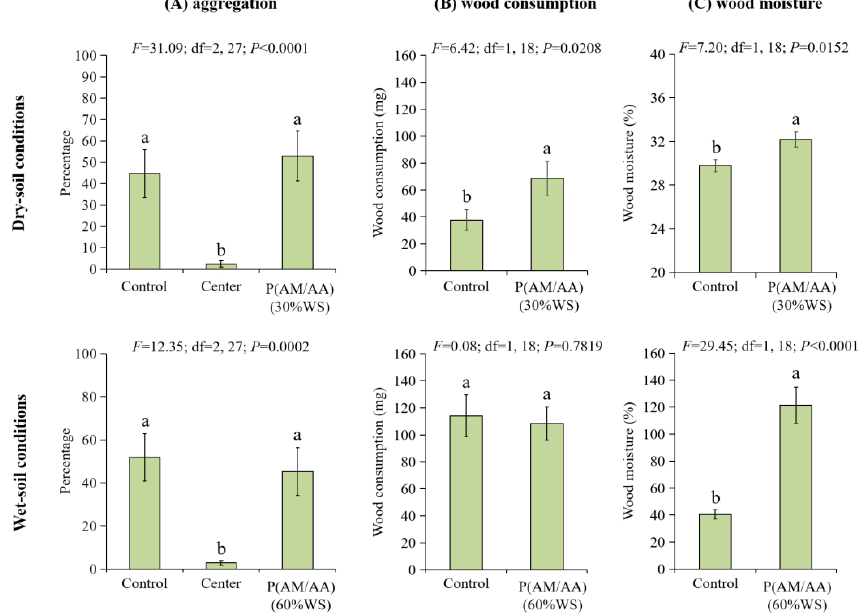
Figure 5. Results of the two-choice tests (under dry- or wet-soil conditions) to investigate the preference of termites to poly(acrylamide-co-acrylic acid) potassium salt (P(AM/AA)) placed within soil. Percentage of termites in each chamber ( A ), and wood consumption ( B ) and wood moisture ( C ) in the side chambers are presented as mean ± SE. Different letters indicate significant differences ( p < 0.05). WS represents water saturation level.